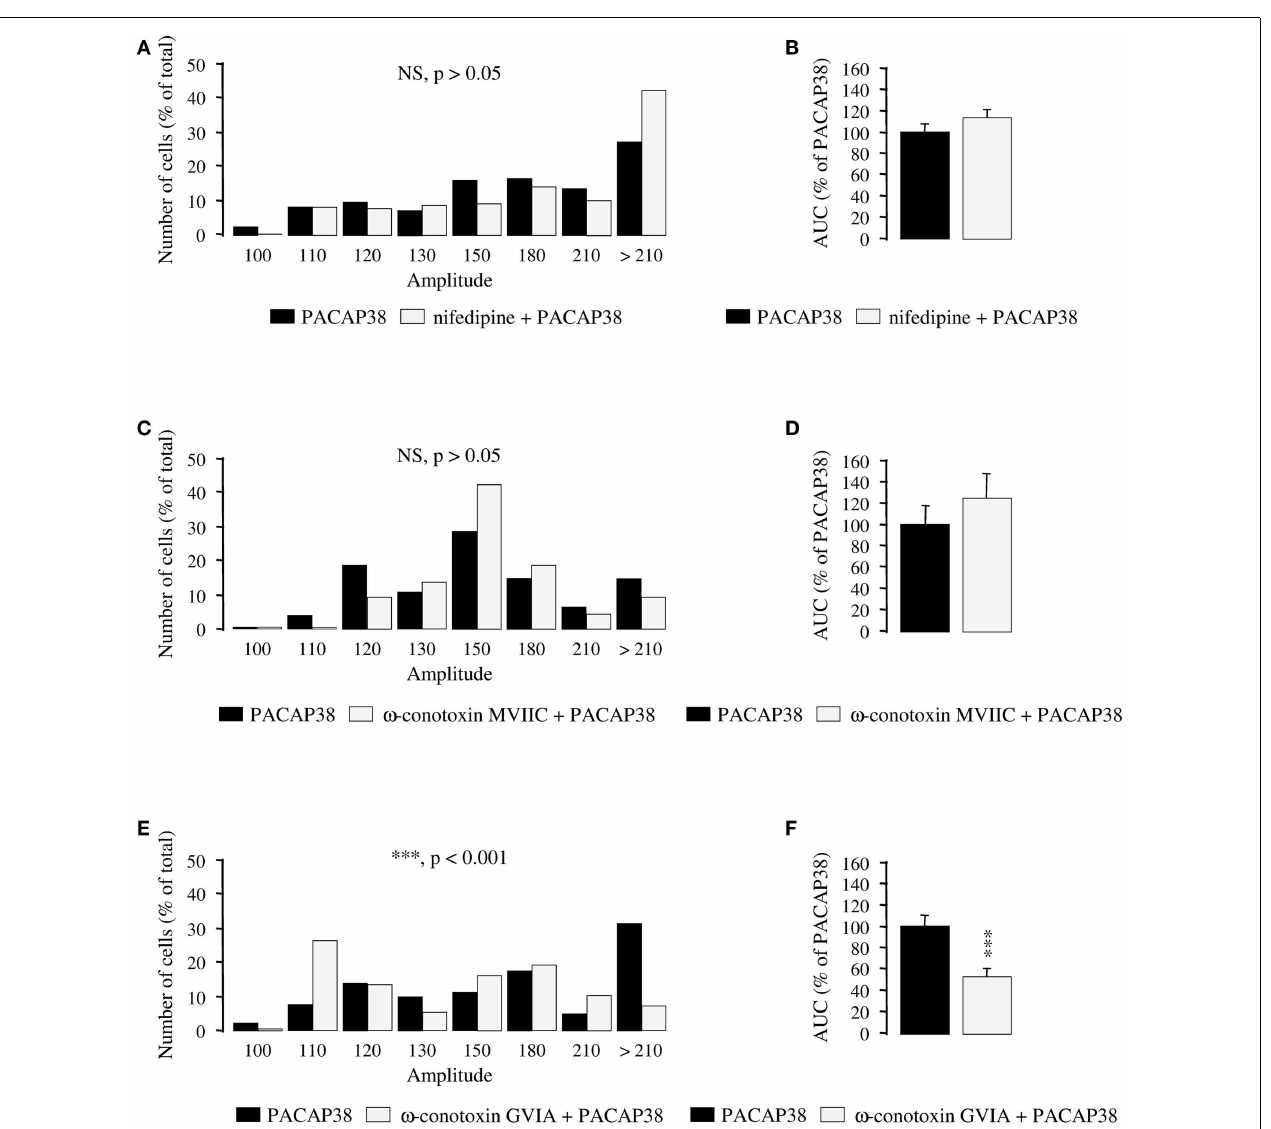
N-type Ca 2 + channel blocker ω -conotoxin GVIA (E,F) . Nifedipine, ω -conotoxin MVIIC, and ω -conotoxin GVIA were added to the incubation medium 30min before application of the pulse of PACAP38. (A,C,E) Histograms showing the distribution of granule cells according to the amplitude of their response to PACAP. Each graph represents the analysis of a least 50 cells from 3 different cultures. AUC, area under the curve; NS, not significantly different from the PACAP38; *** p <